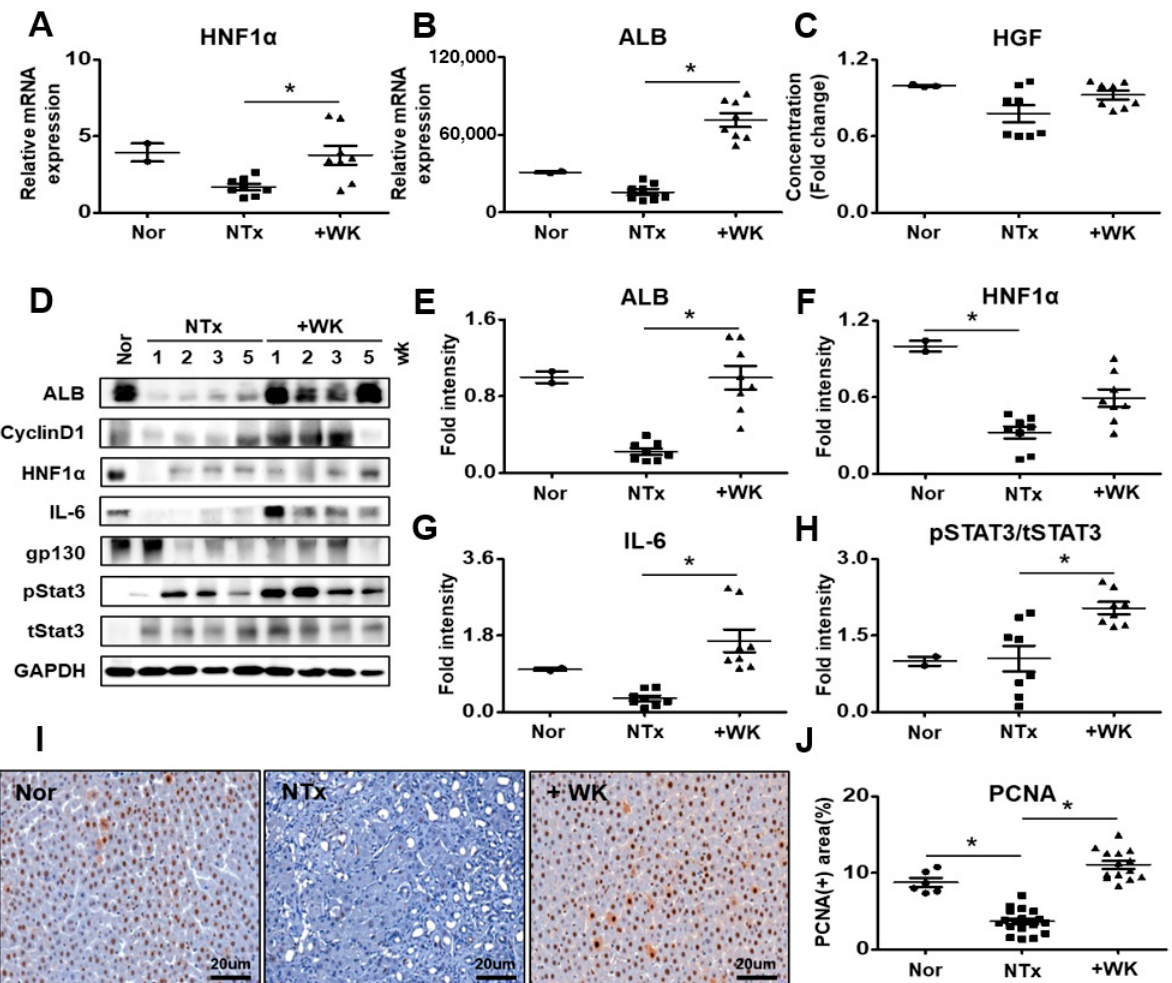
Figure 5. WKYMVm promotes hepatic regeneration in the BDL rat model. The mRNA levels of hepatocyte nuclear factor 1 α (HNF1 α ) ( A ) and albumin (ALB) ( B ) in the livers of normal, BDL, and WKYMVm-treated BDL rats were analyzed by qRT-PCR. ( C ) The serum level of HGF was determined by ELISA. ( D ) The protein expression of ALB, CyclinD1, HNF1 α , IL-6, gp130, pSTAT3 and tSTAT3 was determined by western blot analysis. The intensity of western bands such as ALB ( E ), HNF1 α ( F ), IL-6 ( G ), and STAT3 (H) normalized by GAPDH. ( I ) Immunohistochemistry of PCNA in liver sections. ( J ) Quantification of the percentage of PCNA-positive cells. Mean ± SD ( n = 3 per group), * p < 0.05; one-way ANOVA. Nor, normal control group; NTx, untreated BDL group; +WK, WKYMVm-treated BDL group; wk,